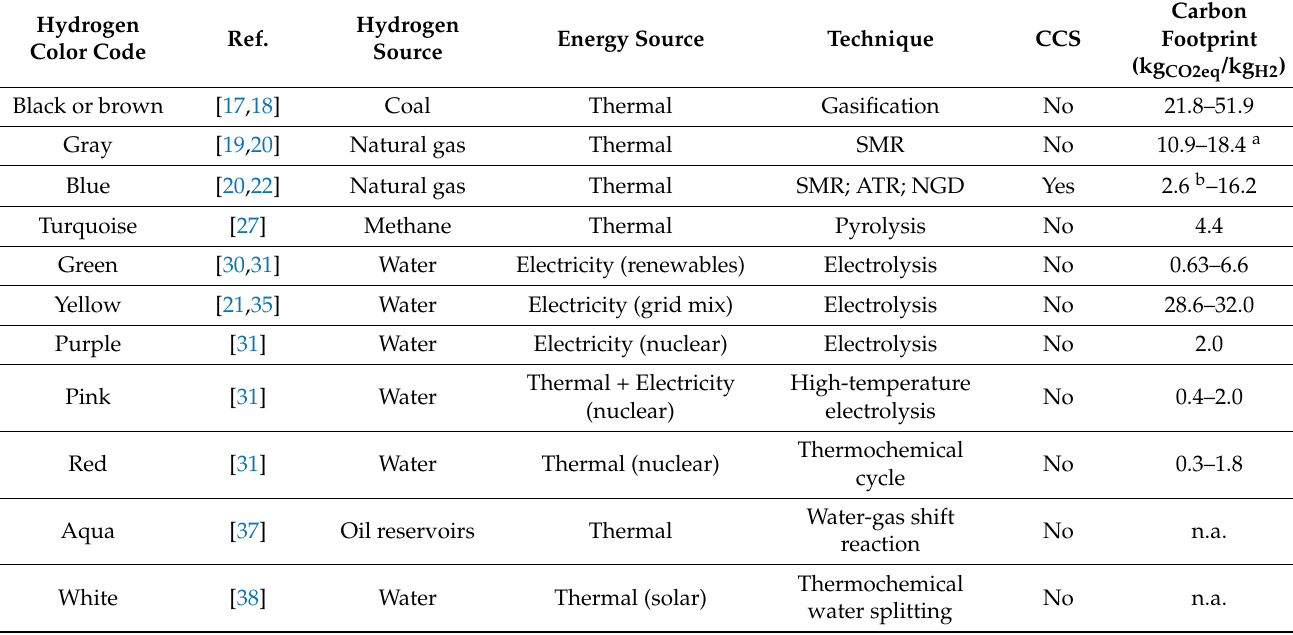
Table 2. Hydrogen color codes, sources, and their carbon footprints (abbreviations: CCS: carbon capture and storage; SMR: steam methane reforming; ATR: autothermal reforming; NGD: natural gas decomposition; n.a.: not